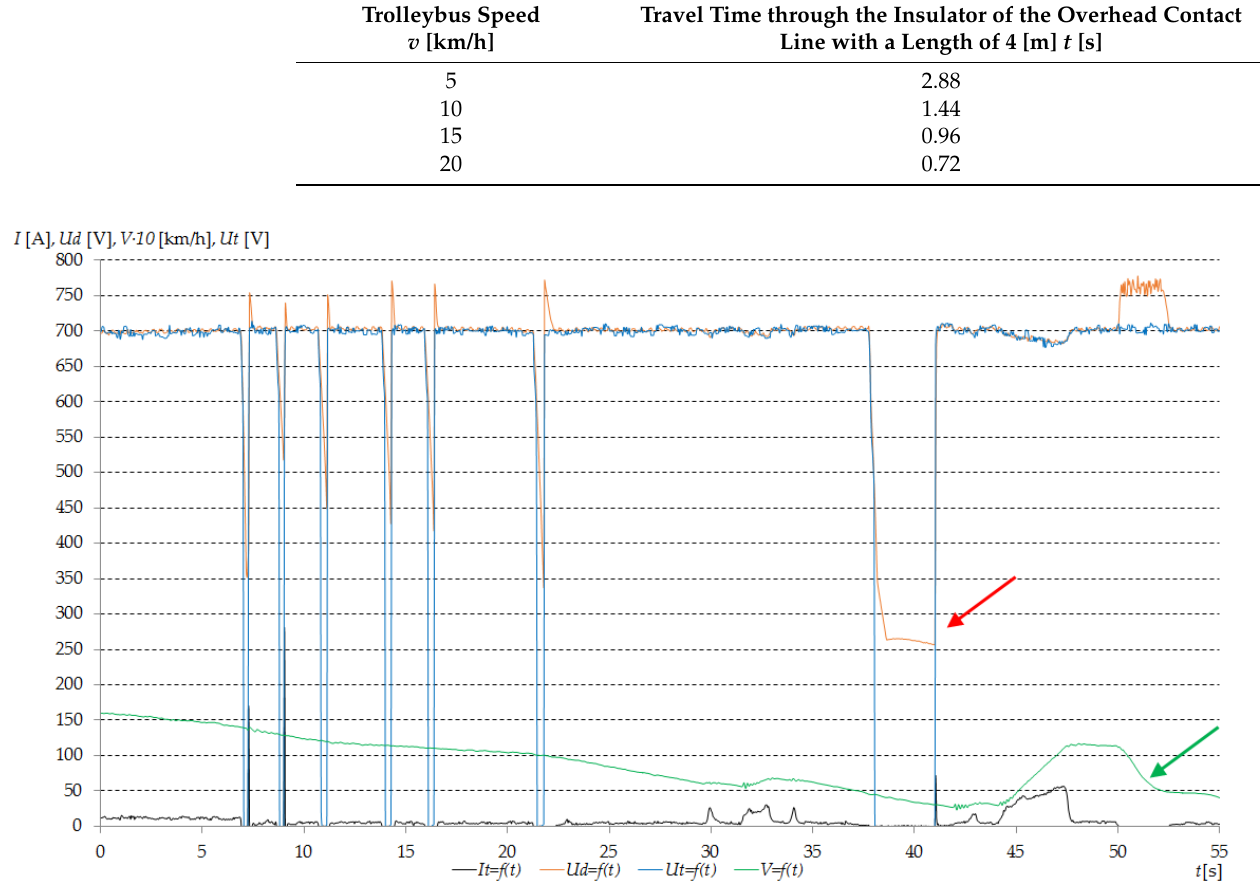
Figure 2. Curves of time vs. traction network current I [A] (black line), traction network voltage Ut [V] (blue line), trolleybus speed (scale × 0.1) v [km/h] (green line), and traction inverter DC link voltage Ud [V] for a trolleybus passing through a series of section insulators [21].